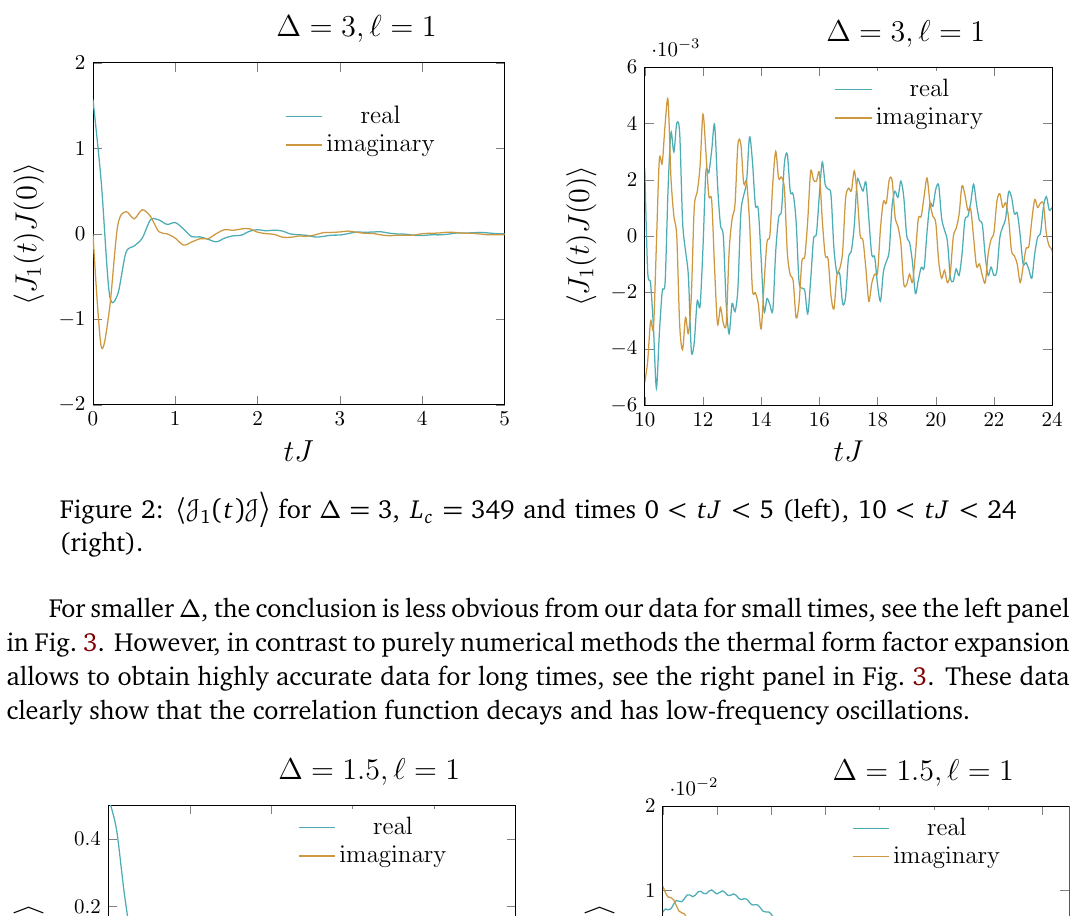
= 349 and times 0 < tJ < 5 (left), 10 < tJ < 24 c